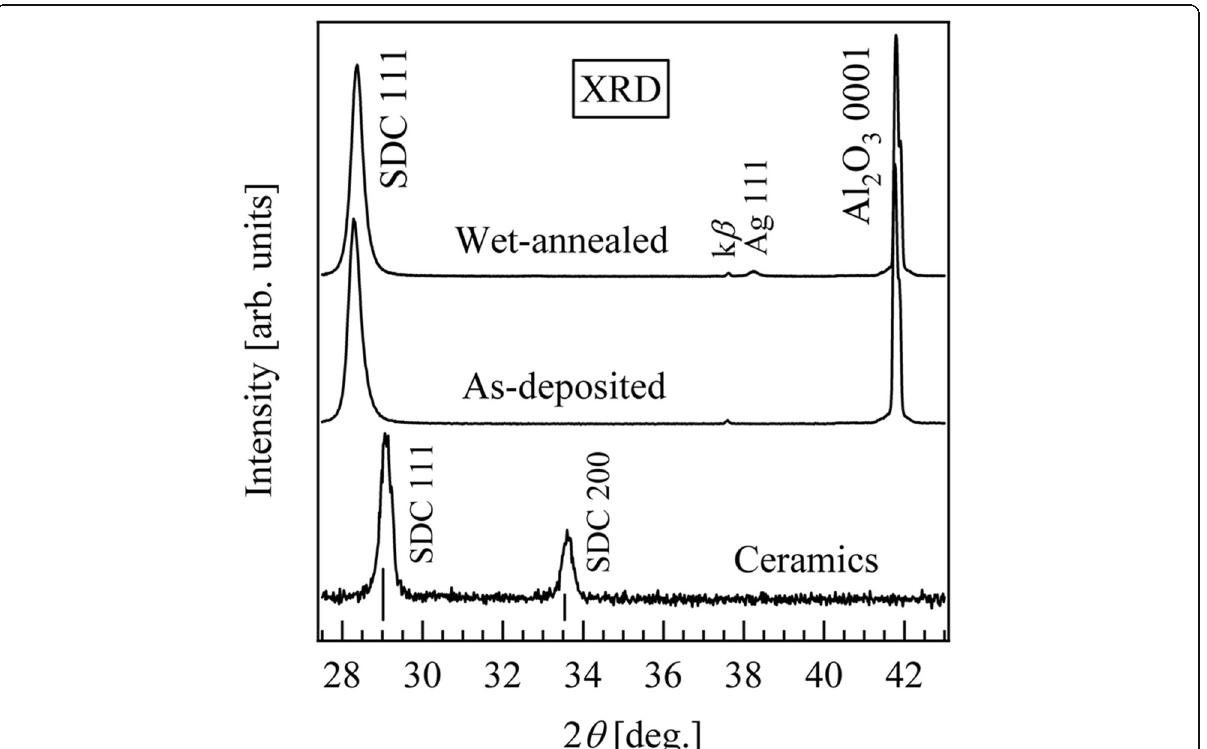
Fig. 1 XRD patterns of the as-deposited, wet-annealed SDC thin films and SDC ceramic. The two solid vertical lines are the CeO 2 (111) and (200)